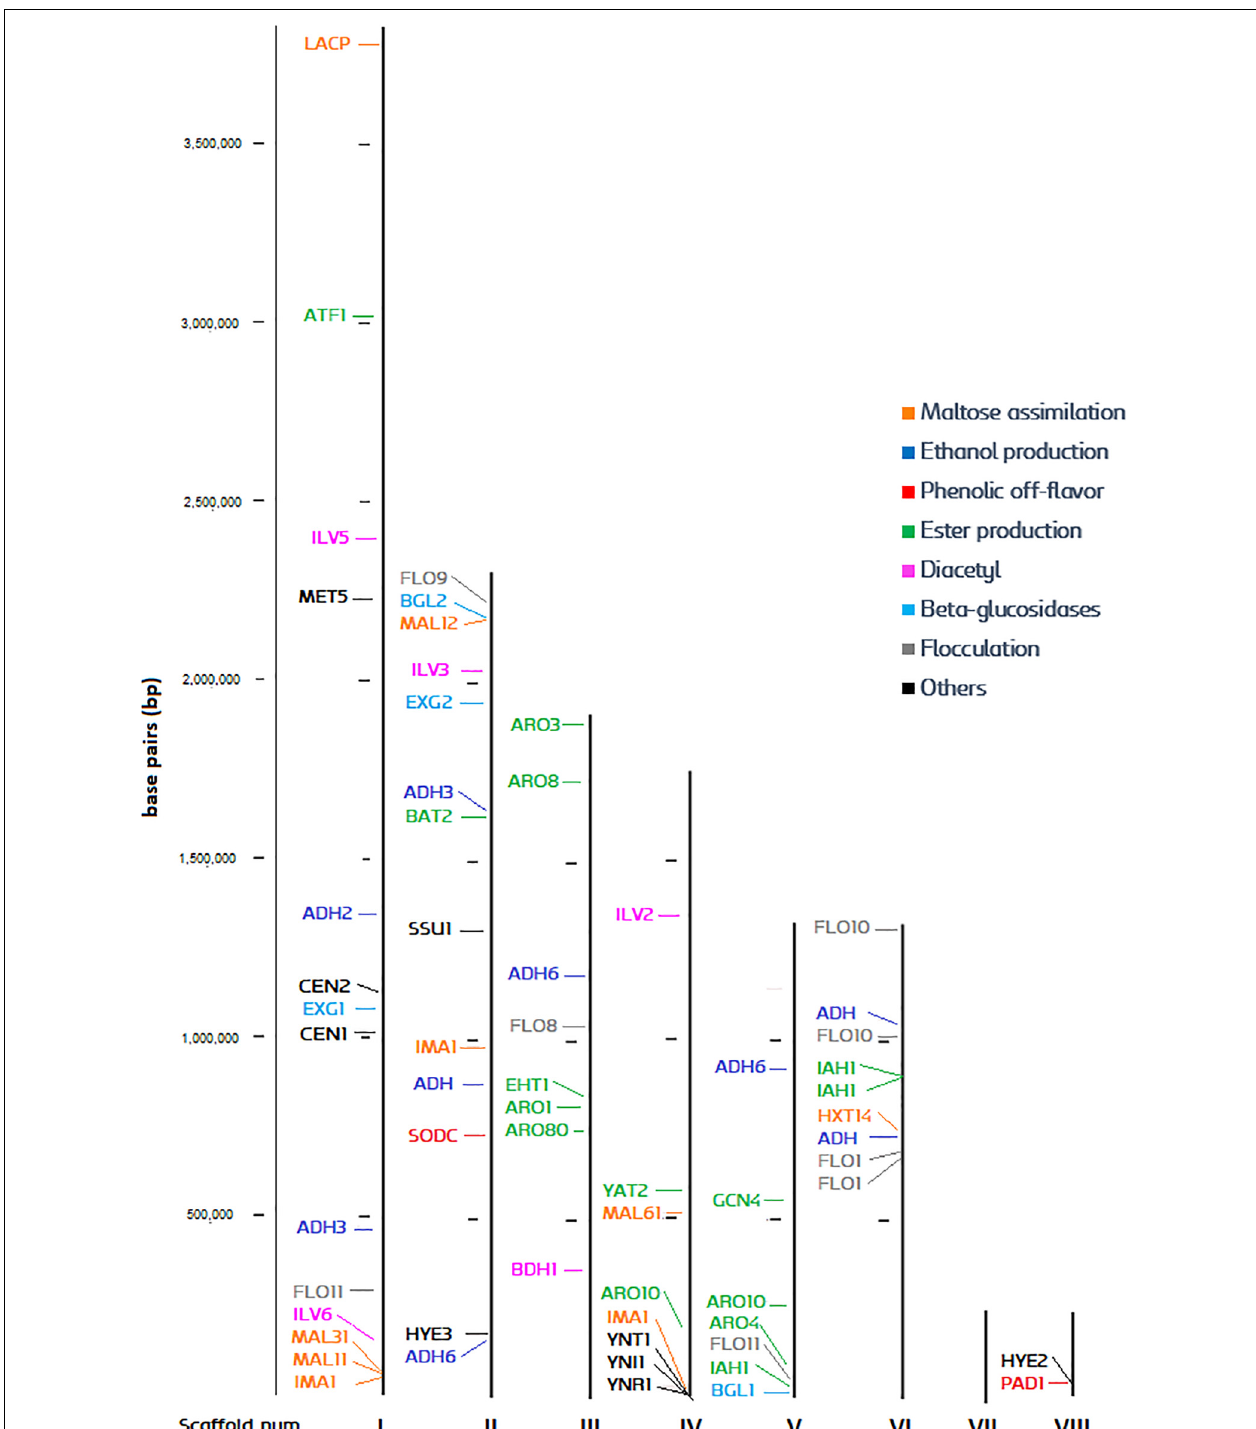
FIGURE 3 | Distribution of brewing-relevant genes across the B. bruxellensis UMY321 reference genome.